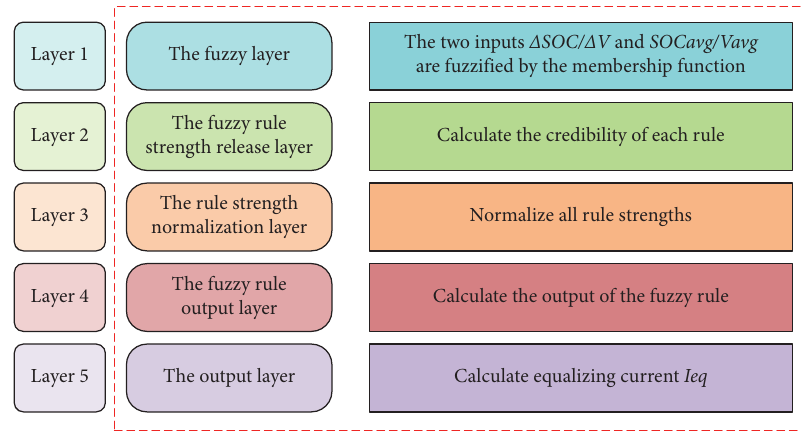
Figure 10: Structure of the adaptive fuzzy neural